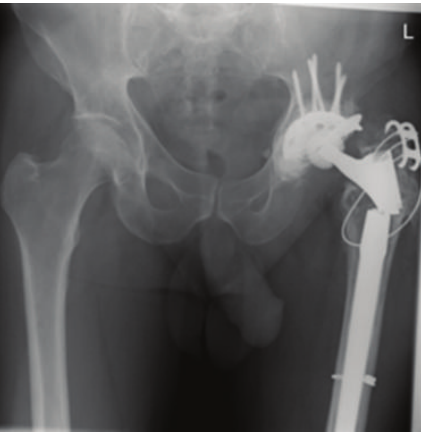
Figure 1: Plain AP pelvic radiograph of broken Revitan stem.